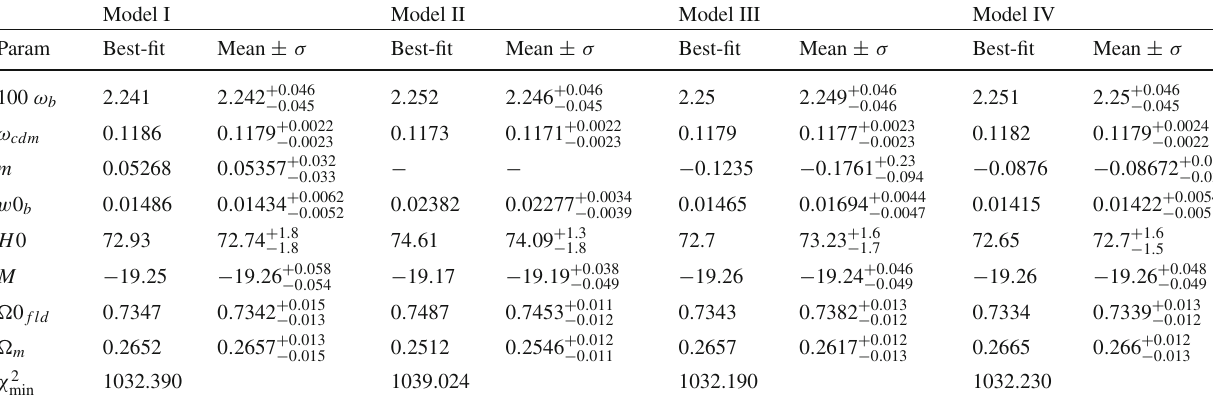
Table 2 Best fit values of model parameters for different models using data set II (Pantheon + BAO +